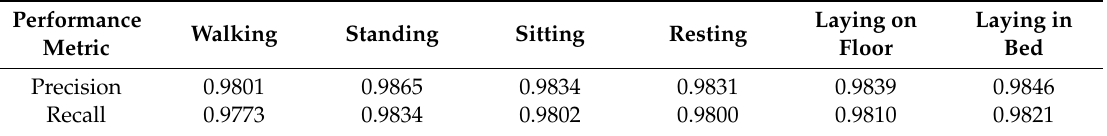
Table 4. Performance Evaluation of the Euclidean distance model for sampled activities of daily living